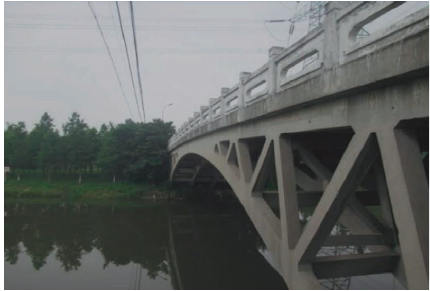
Figure 4: Side view of the